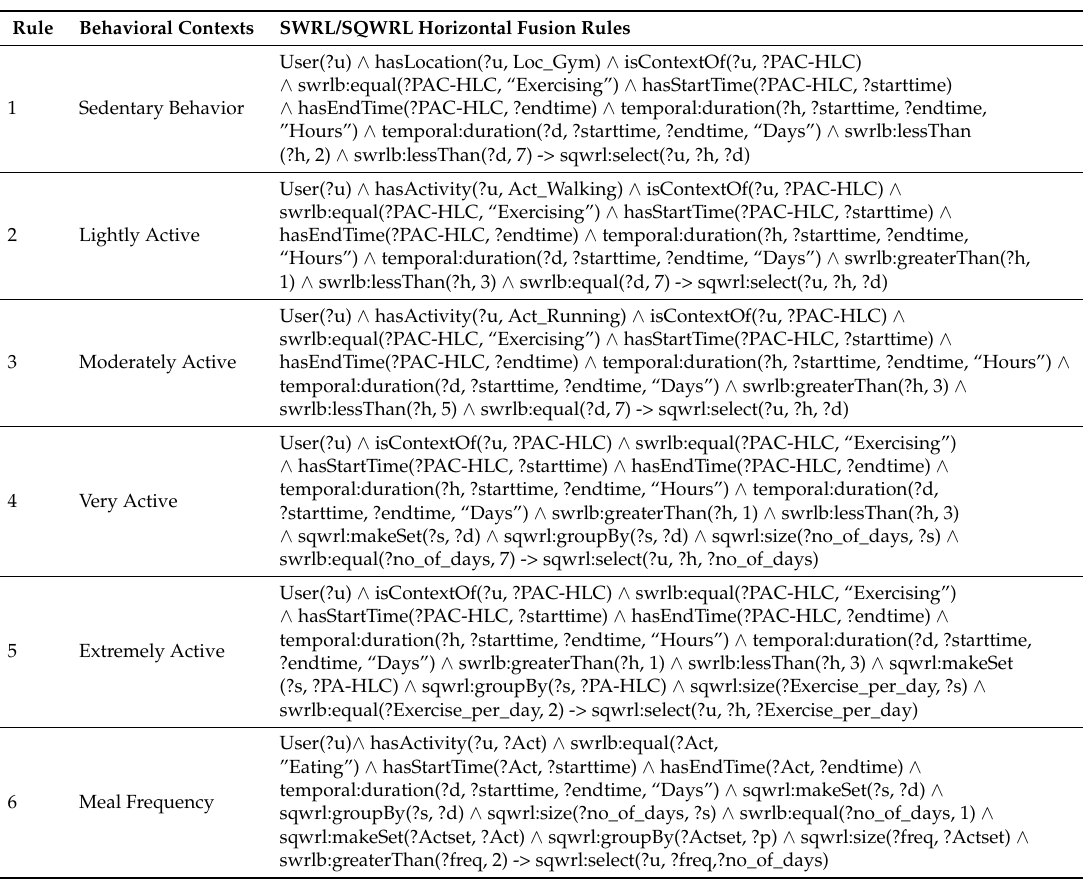
Table 3. SWRL/SQWRL definitions: PA-HLC, N-HLC and LLC involved in Horizontal Fusioning for Behavior